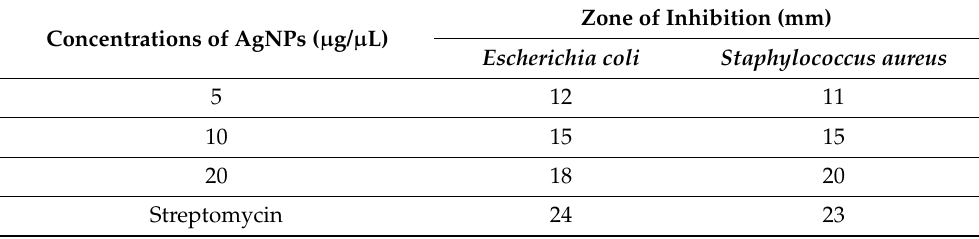
Table 1. Table showing different volumes of AgNPs used against Escherichia coli and Staphylococcus aureus in the disc diffusion method.